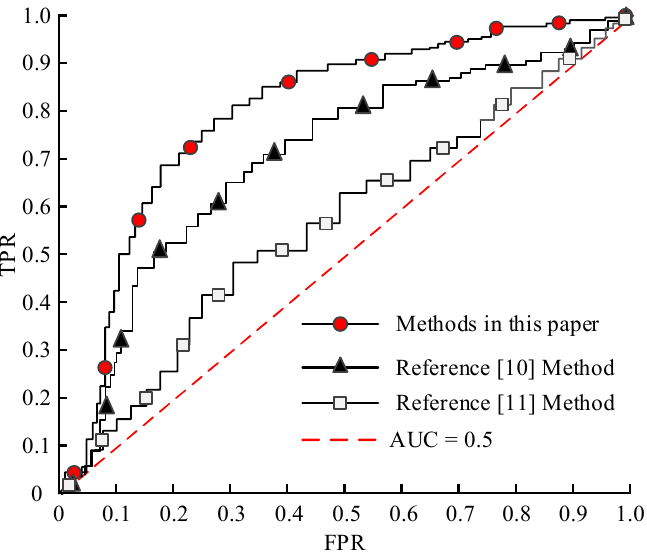
Figure 14. ROC curve of fault classification [10,11].